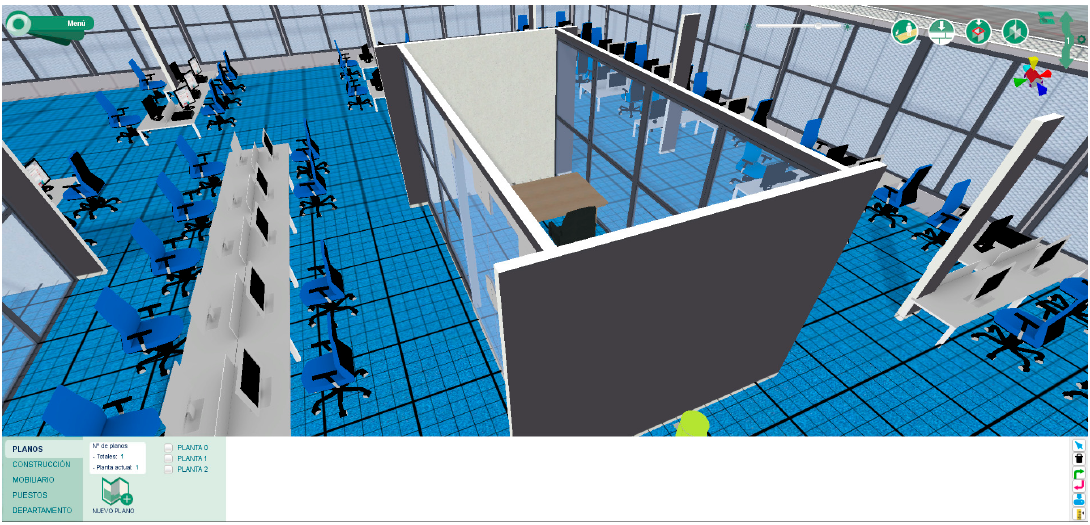
Figure 3. The 3D edition environment.